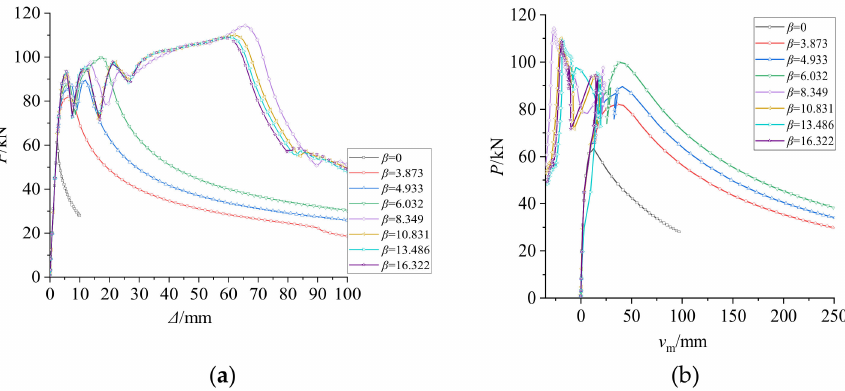
Figure 15. Effect of core flexural rigidity ratio: ( a ) P - ∆ relationships; ( b ) P - v m